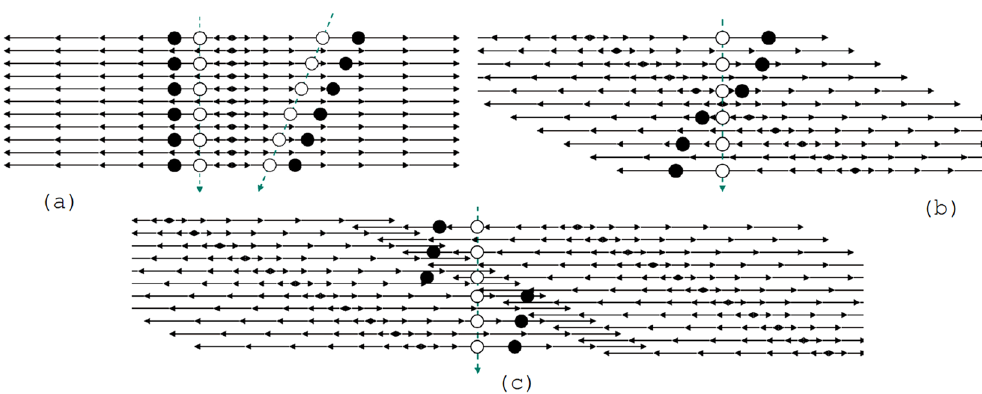
Figure 7. Distortion of a vertical and an inclined track passing through emulsion in the SG ( a ). Distortion ( b ) and breakage ( c ) of a vertical track passing through emulsion in the CM. In all figures horizontal lines represent grabbed images. Solid horizontal arrows represent distortion strength and direction. Dashed arrows represent particle tracks. Empty circles represent true positions of grains left by passing through particles. Black circles represent the observed grains positions as they are seen due to optical